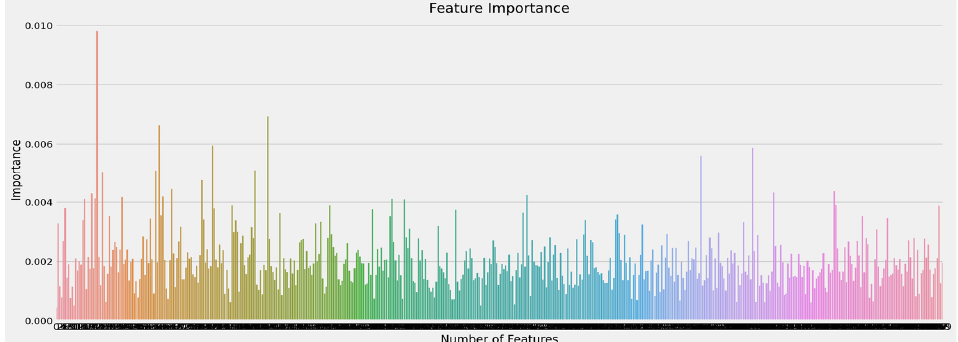
Figure 17. Plot of The Importance of The Input Features.